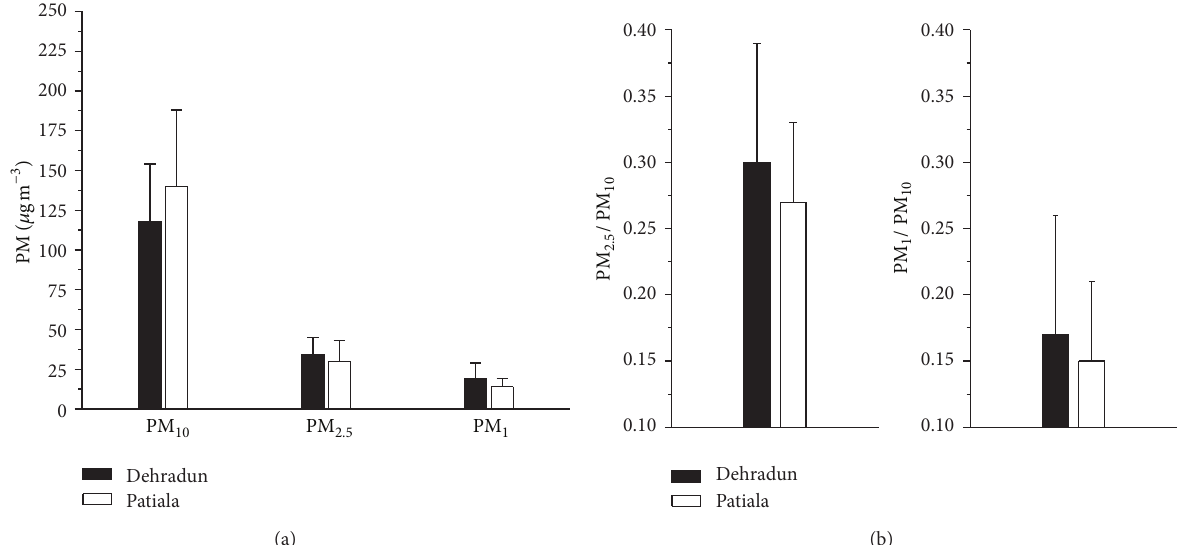
Figure 2: The variation of seasonal average (a) particulate mass concentration (PM 10 , PM 2.5 , and PM 1 ) and (b) FMF over Dehradun and Patiala.